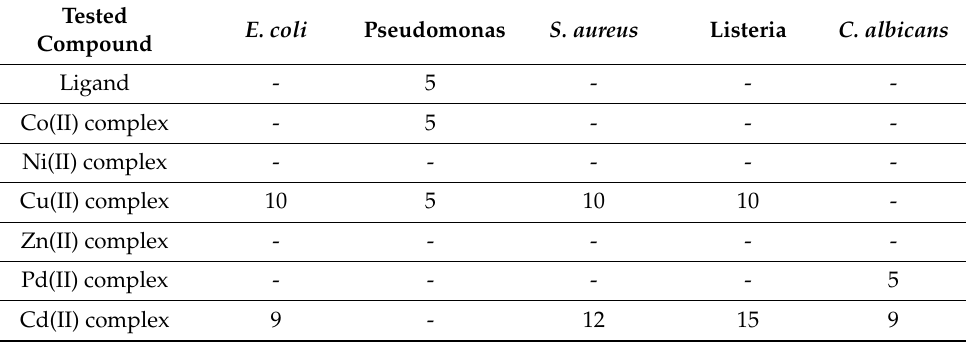
Table 4. Anti-bacterial activity of the ligand and its M(II) complexes expressed as the diameter (mm) of the inhibition zone.